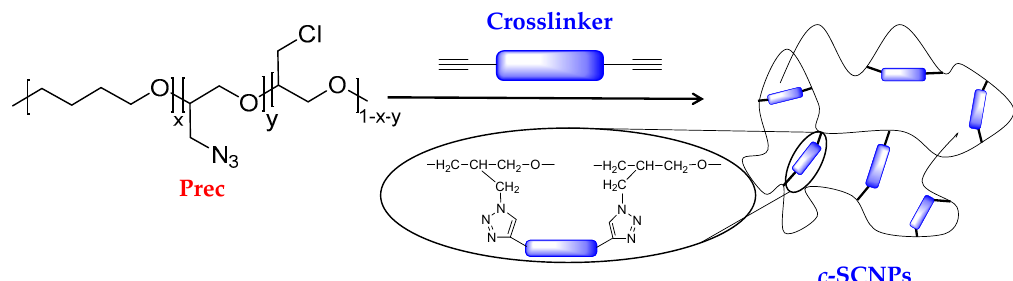
Scheme 1. Schematic representation of the synthesis of SCNPs via “click” chemistry reaction using propargyl ether as homobifunctional cross-linker.